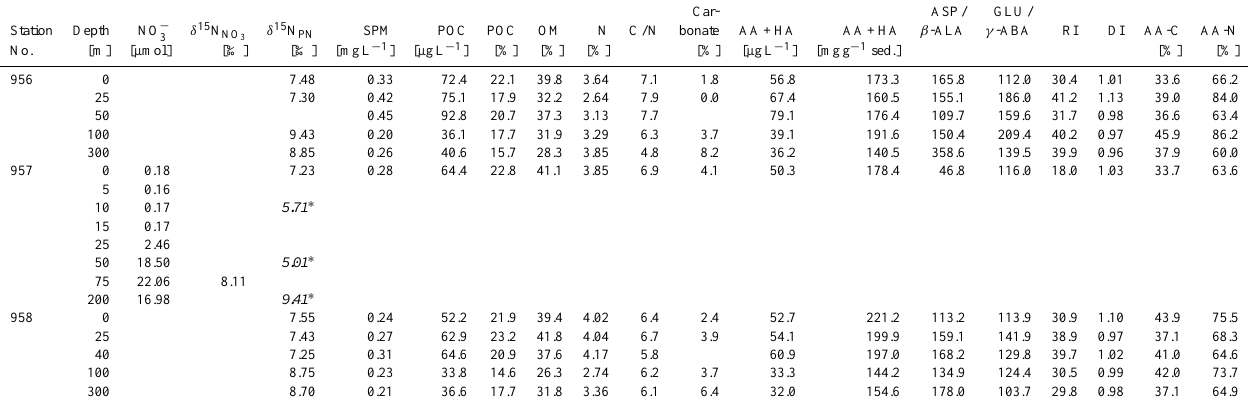
(Table 1). Similar to POC, AA concentrations, AA-C % and AA-N % have no depth trend at stations